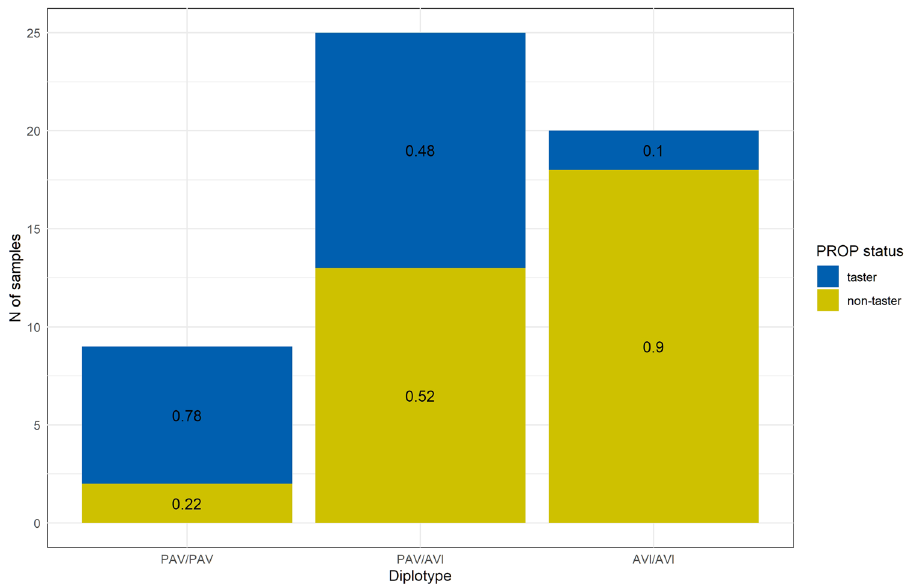
Figure 2. PROP status distribution among TAS2R38